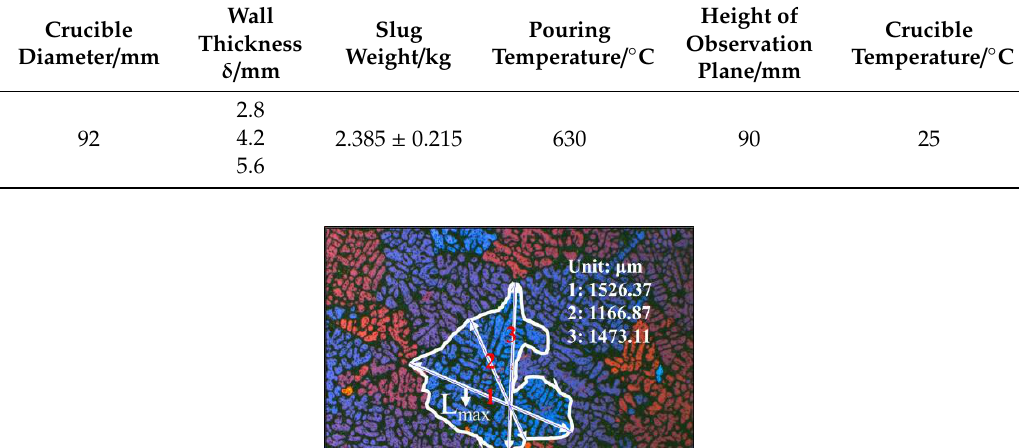
Figure 4. Schematic for the definition of grain size d, d = L max .